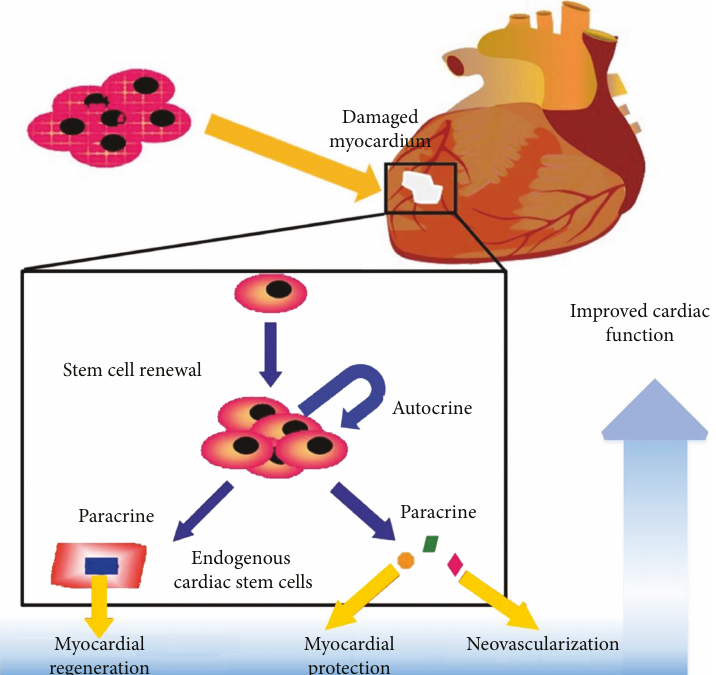
Figure 2: Implantation of hMSCs may repair damaged myocardium via the paracrine mechanisms. hMSCs can secrete various angiogenic factors to support neovascularization, myocardial protection, and regeneration, leading to improved cardiac function in myocardial infarction models. This image is adapted from [108] published under the Creative Common Attribution